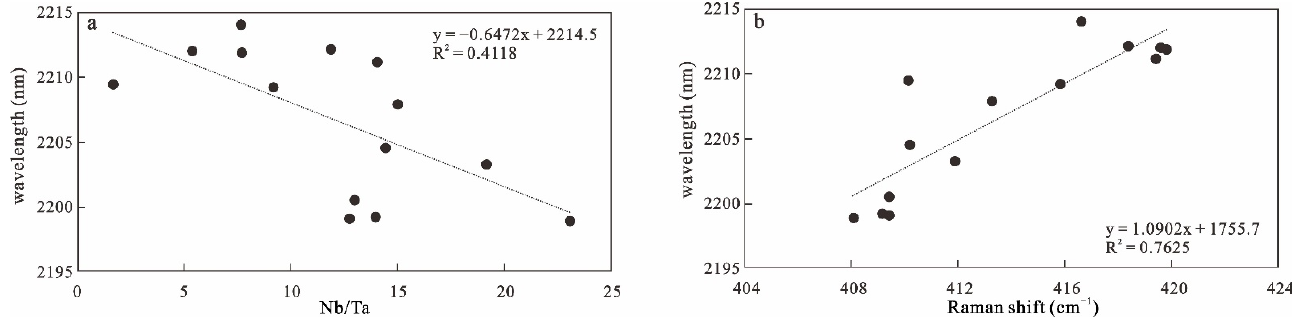
Figure 8. Binary diagram of the SWIR spectra (Pos 2200) for the Shimensi white mica vs. ( a ) Nb/Ta; ( b ) Raman shift (Al, O (br)). ( b ) Raman shift (Al, O